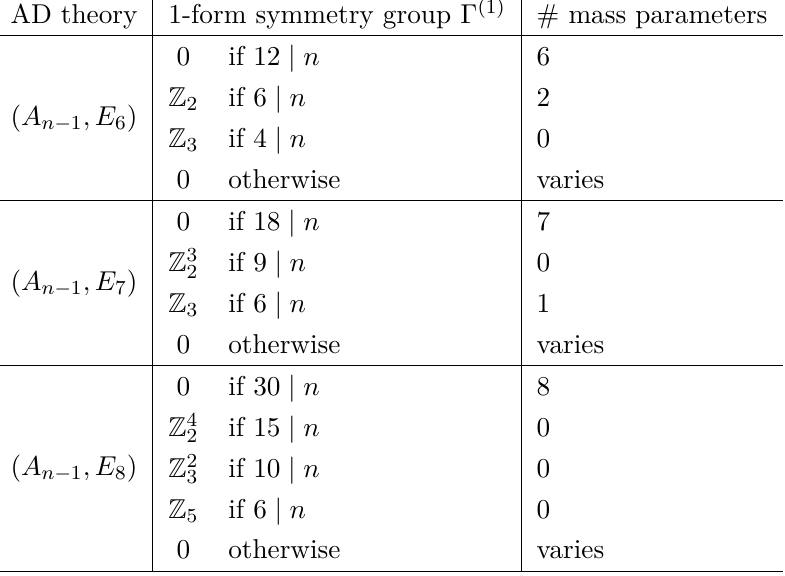
Table 1 . 1 -form symmetry groups and number of mass parameters for theories of type ( A n , E m ) . For theories where the cases overlap, the highest written condition takes